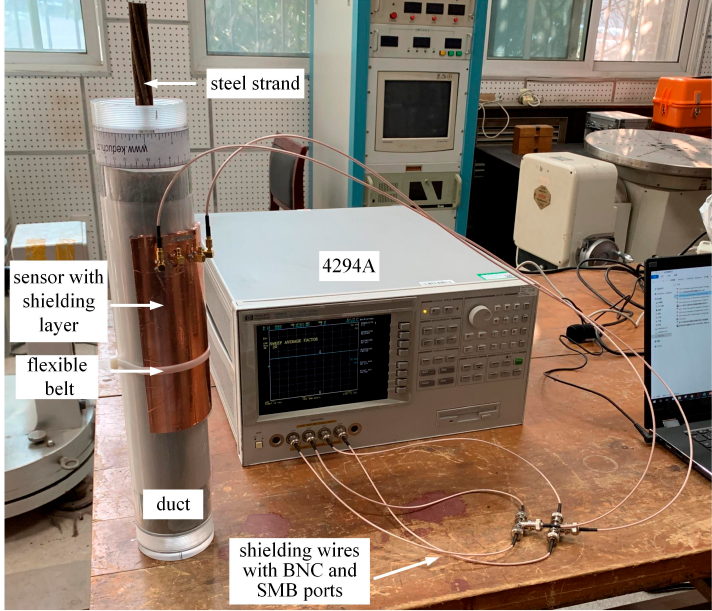
Figure 9. Diagram of the experimental device. Table 3. The measured capacitance (fF) and normalized values between E1 and E4.